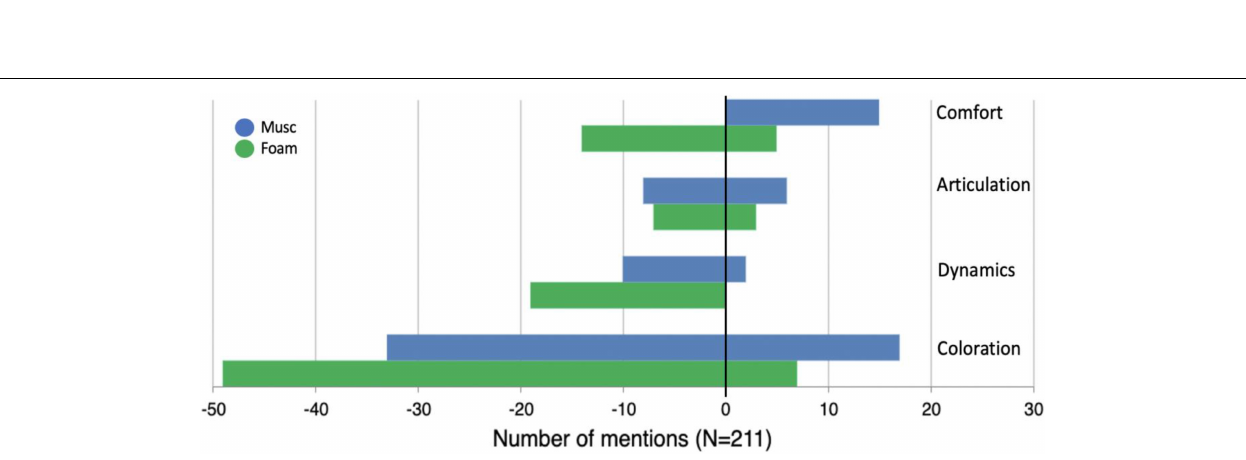
Frontiers in Psychology |